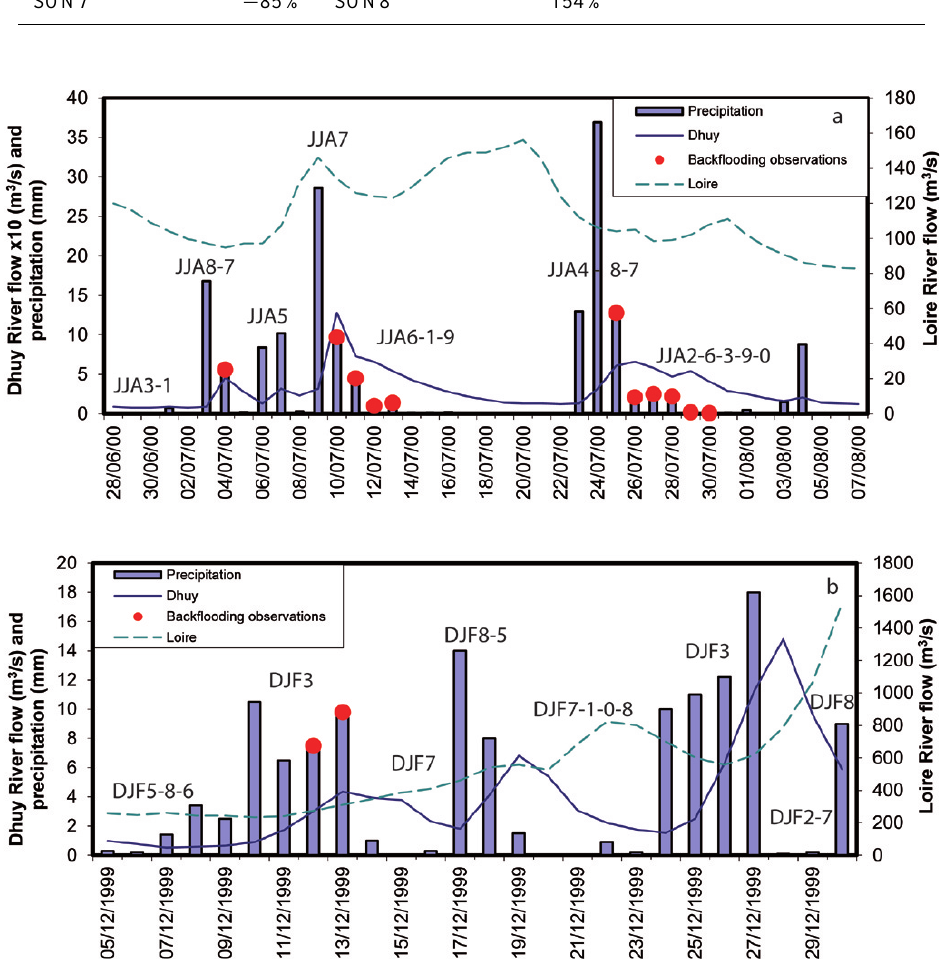
Fig. 6. Precipitations, Loire river flow, Dhuy river flow, backflooding observations and associated WT during a period of Loire stability (a) and a period of Loire high river flow (b)